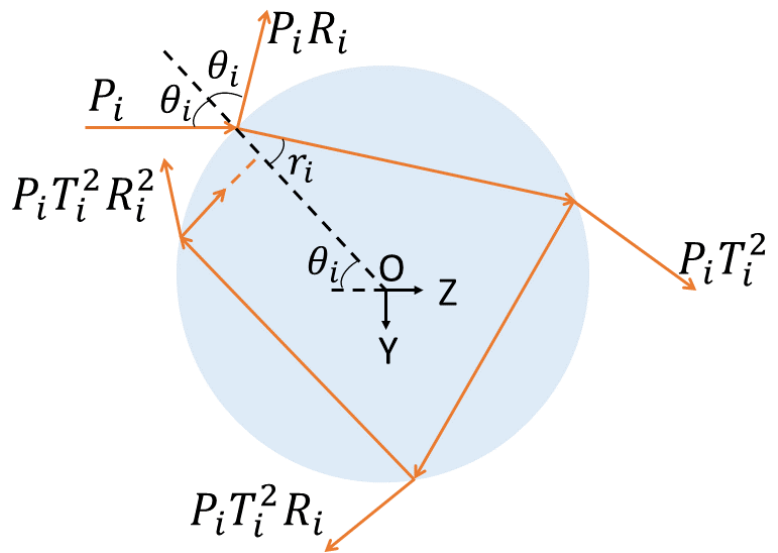
Figure 2. Calculation of the scattering and gradient forces acting on a Mie particle from a single ray, by taking into account geometrical optics and multiple reflection and transmission events, using Fresnel coefficients R and T